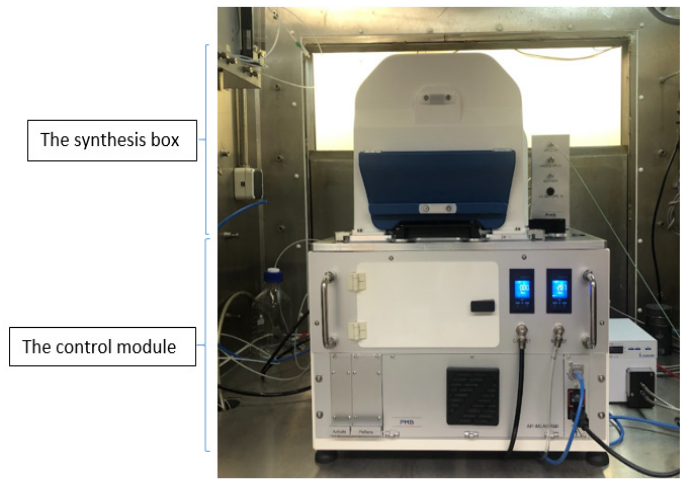
Figure 1. iMiDEV™ automated microfluidic radiosynthesizer.